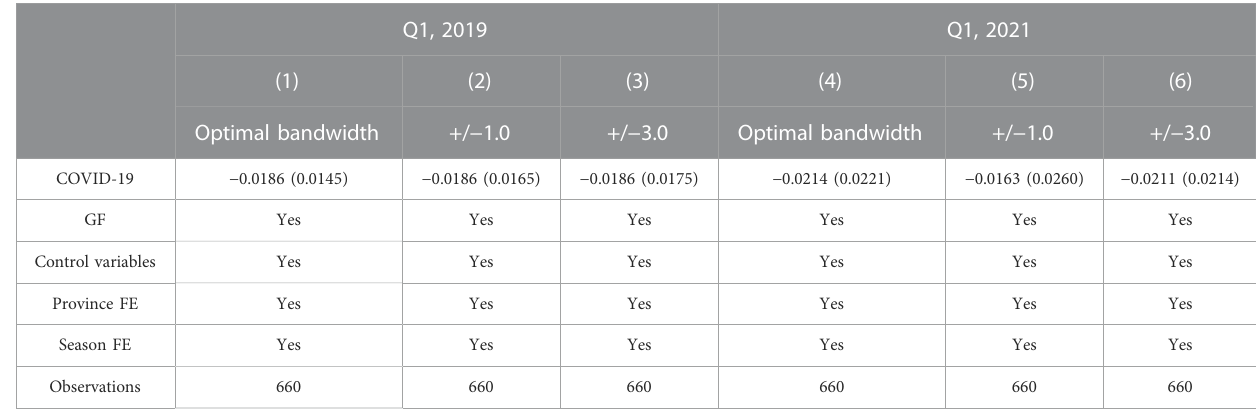
TABLE 6 Robustness test